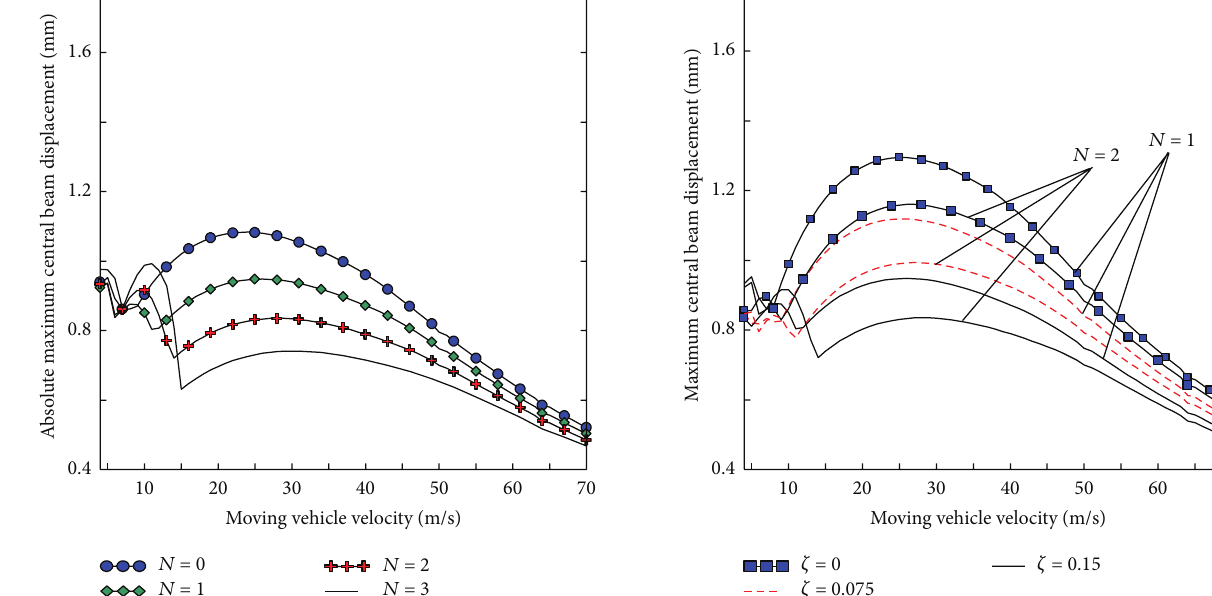
Figure 8: The maximum displacement of the beam at mid-span versus the velocity of the moving vehicle for 𝜁 = 0.15 .